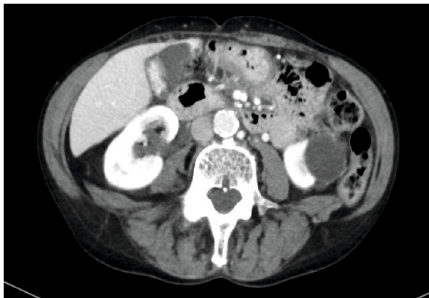
Figure 2: CT abdomen reported cholelithiasis with pericholecystic fl uid.